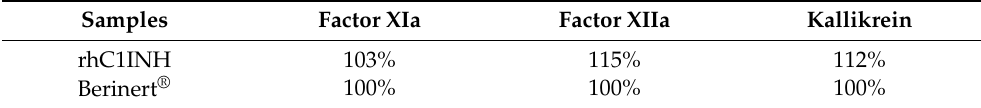
Table 8. Inhibition of C1s subunit by C1INH.